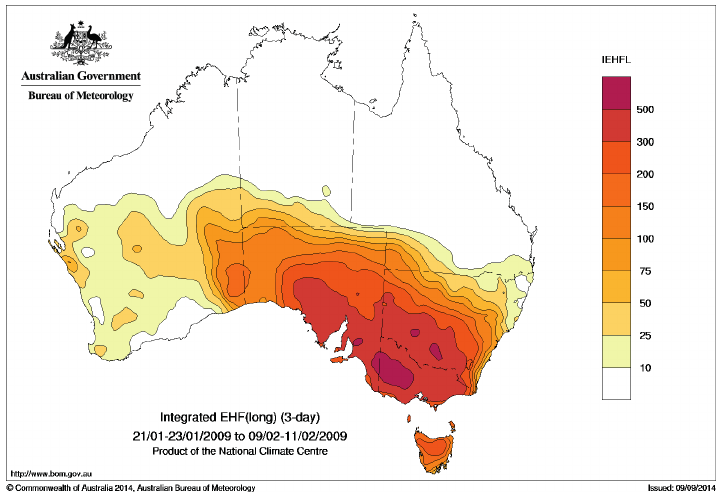
Figure 18. Integrated EHF across the period 21–23 January to 9–11 February